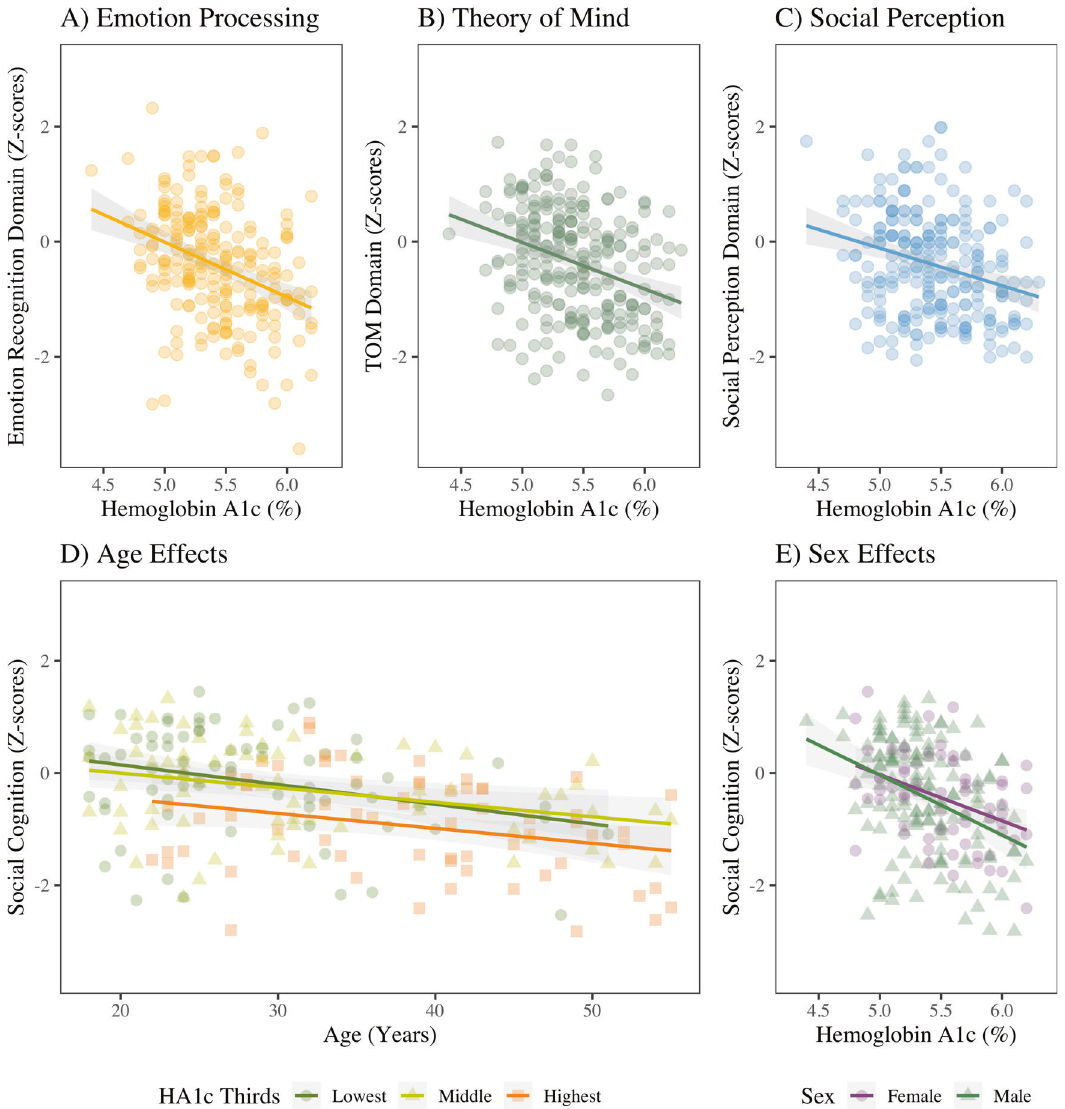
Fig. 2 Hemoglobin A1c and Social Cognition in SSD. Among participants with schizophrenia spectrum disorders (SSD), there was a signi fi cant inverse relationship between hemoglobin A1c and each domain of social cognition: ( A ) Emotion Processing ( β = − 0.36, p < 0.001), B Theory of Mind ( β = − 0.31, p < 0.001), and ( C ) Social Perception ( β = − 0.27, p < 0.001). D Age was also related to greater impairment in aggregate social cognition ( β = − 0.40, p < 0.001), but elevated HbA1c in the top third of the SSD group ( ≥ 5.7%) was related to still greater impairment ( β = − 0.25, p = 0.001). E There was no signi fi cant effect of sex on the relationship between HbA1c and aggregate social cognition ( β = 0.01, p = 0.93). Standardized β coef fi cients are